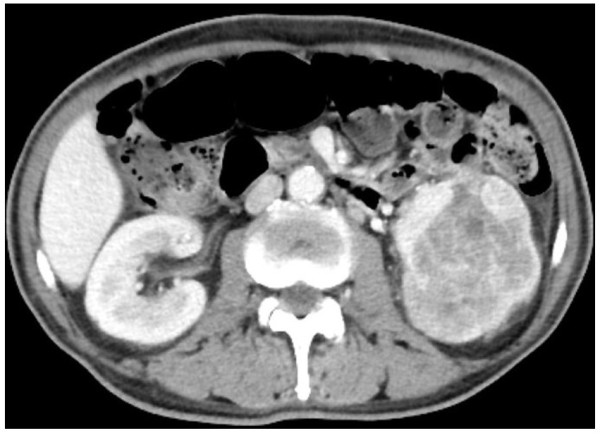
Abdominal enhanced computed tomography (CT) before axitinib treatment. (coronal section) Abdominal CT shows a hypervascular tumor (size, 9 × 8.5 cm) in the lower pole of the left kidney.